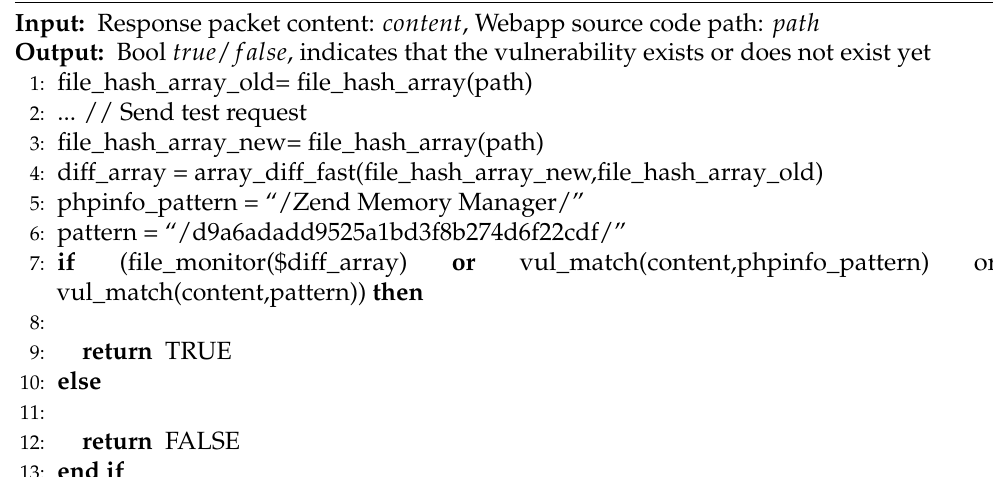
Algorithm 3 Vulnerability